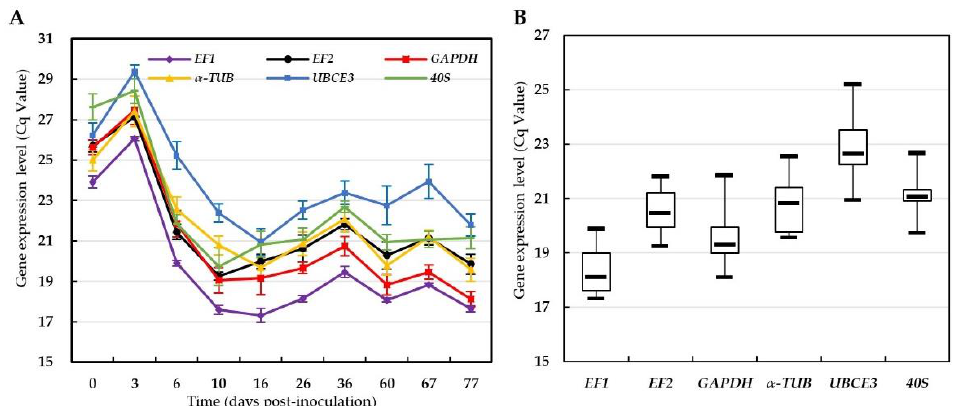
Figure 1. Cq values for the candidate reference genes. ( A ) Plot of Cq values of the candidate reference genes in the test infection stages; ( B ) Box plots of the Cq values of the candidate reference genes from the samples except 0 dpi and 3 dpi. The boxes depict the quartiles, the bars in the box plots denote the minimum and maximum values, and the line in the box indicates the median value.